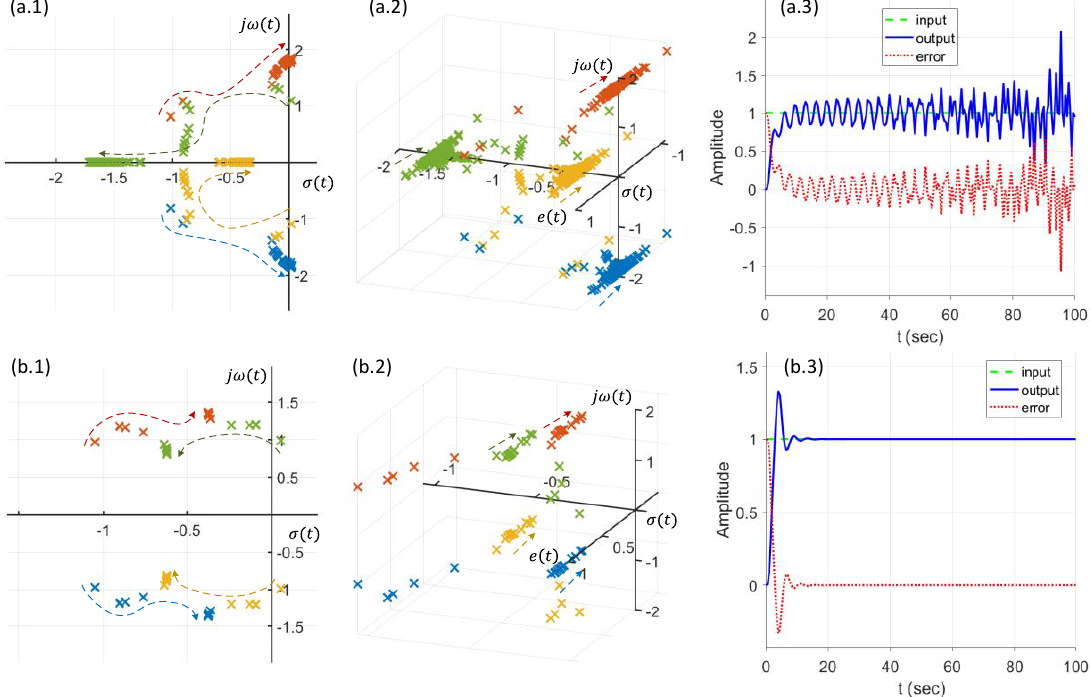
Figure 10. Dynamic pole motions of the controlled hybrid soft leg and the controlled system response by error change with the gains of ( a ) 𝐾 𝑝𝑓 = 1.5 , 𝐾 𝑣𝑓 = 4 , 𝛼 = 1 , and 𝛽 = 2 , and ( b ) 𝐾 𝑝𝑓 = 0.1 , 𝐾 𝑣𝑓 = 0.3 , 𝛼 = 1 , and 𝛽 = 2 . The arrows indicate the direction of pole motions.